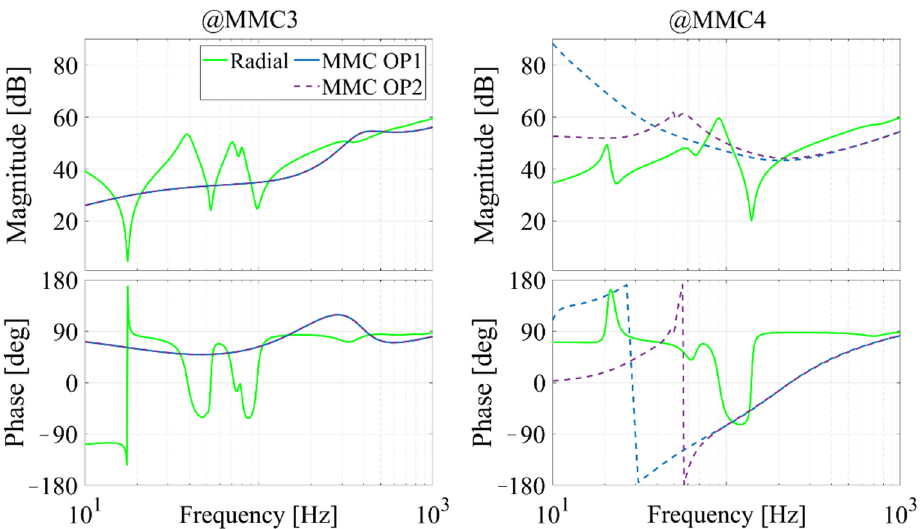
Figure 14. Impedance of MMC station 3&4 and network impedance seen from the terminals of MMC stations 3&4.